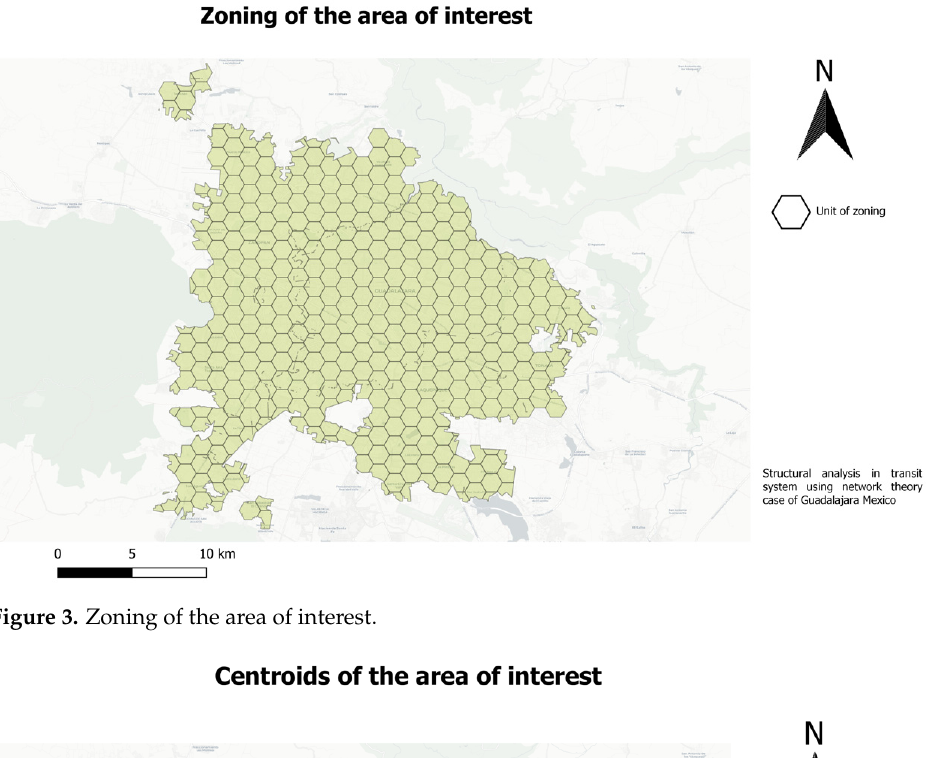
Figure 3. Zoning of the area of interest.